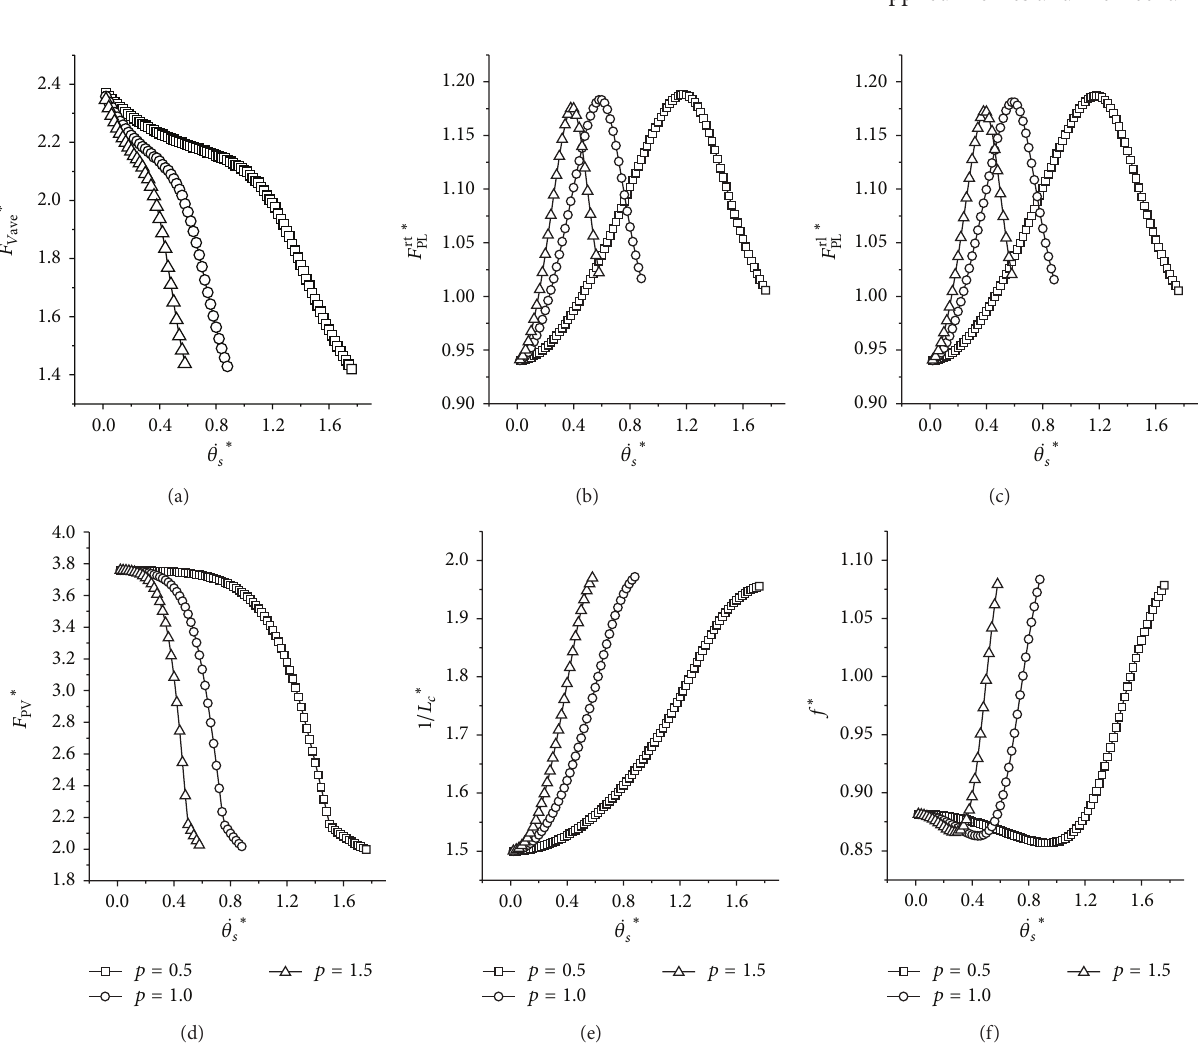
varying the leading leg which bears the most loads,